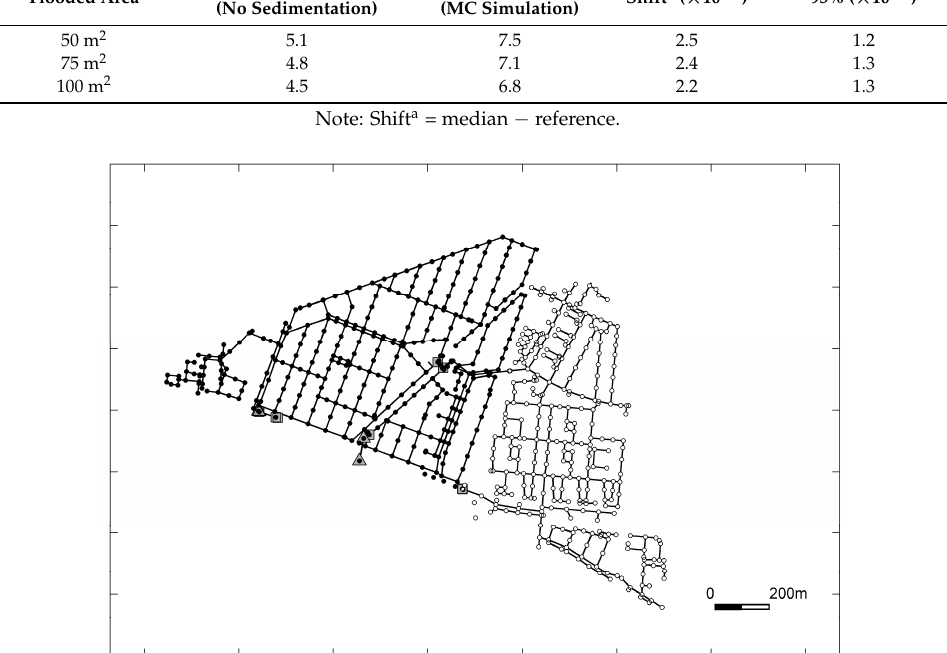
Figure 10. Spatial distribution of children in the ‘Tuindorp’ catchment: black dots (21% of population) and white dots (12% of population) [34].